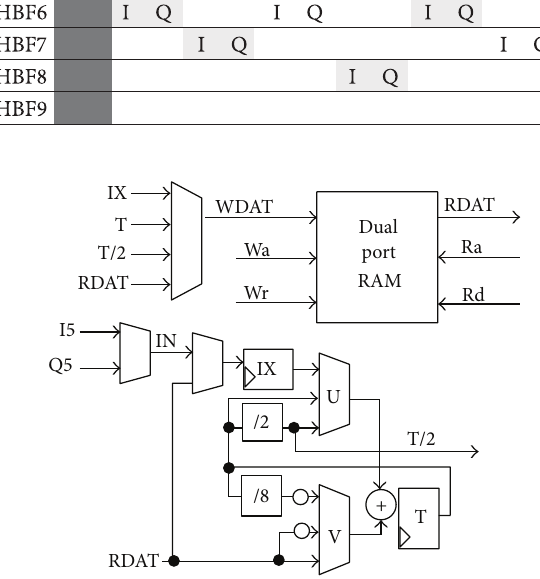
Figure 5: Hardware resources for the complete filter.